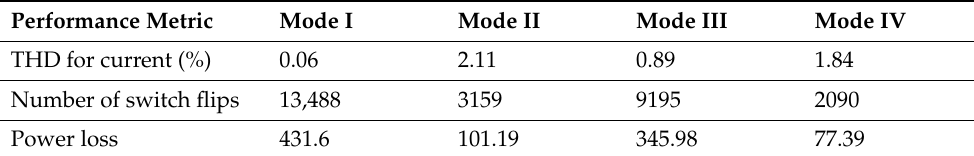
Table 3. Comparison of the four modes of operation.